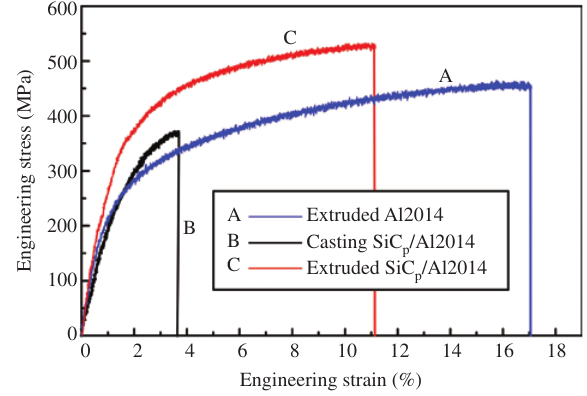
/Al2014 composites (A) before and (B) after extrusion. p